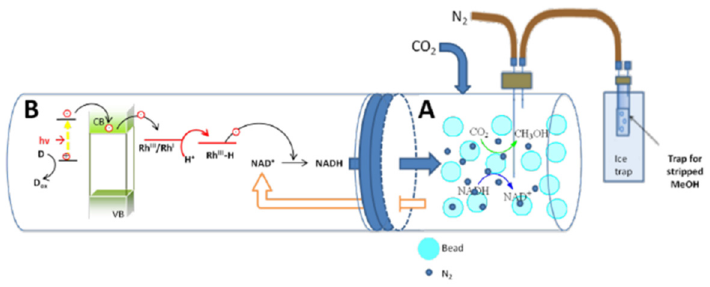
Figure 4. Two-compartment systems for photocatalytic cofactor regeneration in the enzymatic reduction of CO 2 to CH 3 OH [67].